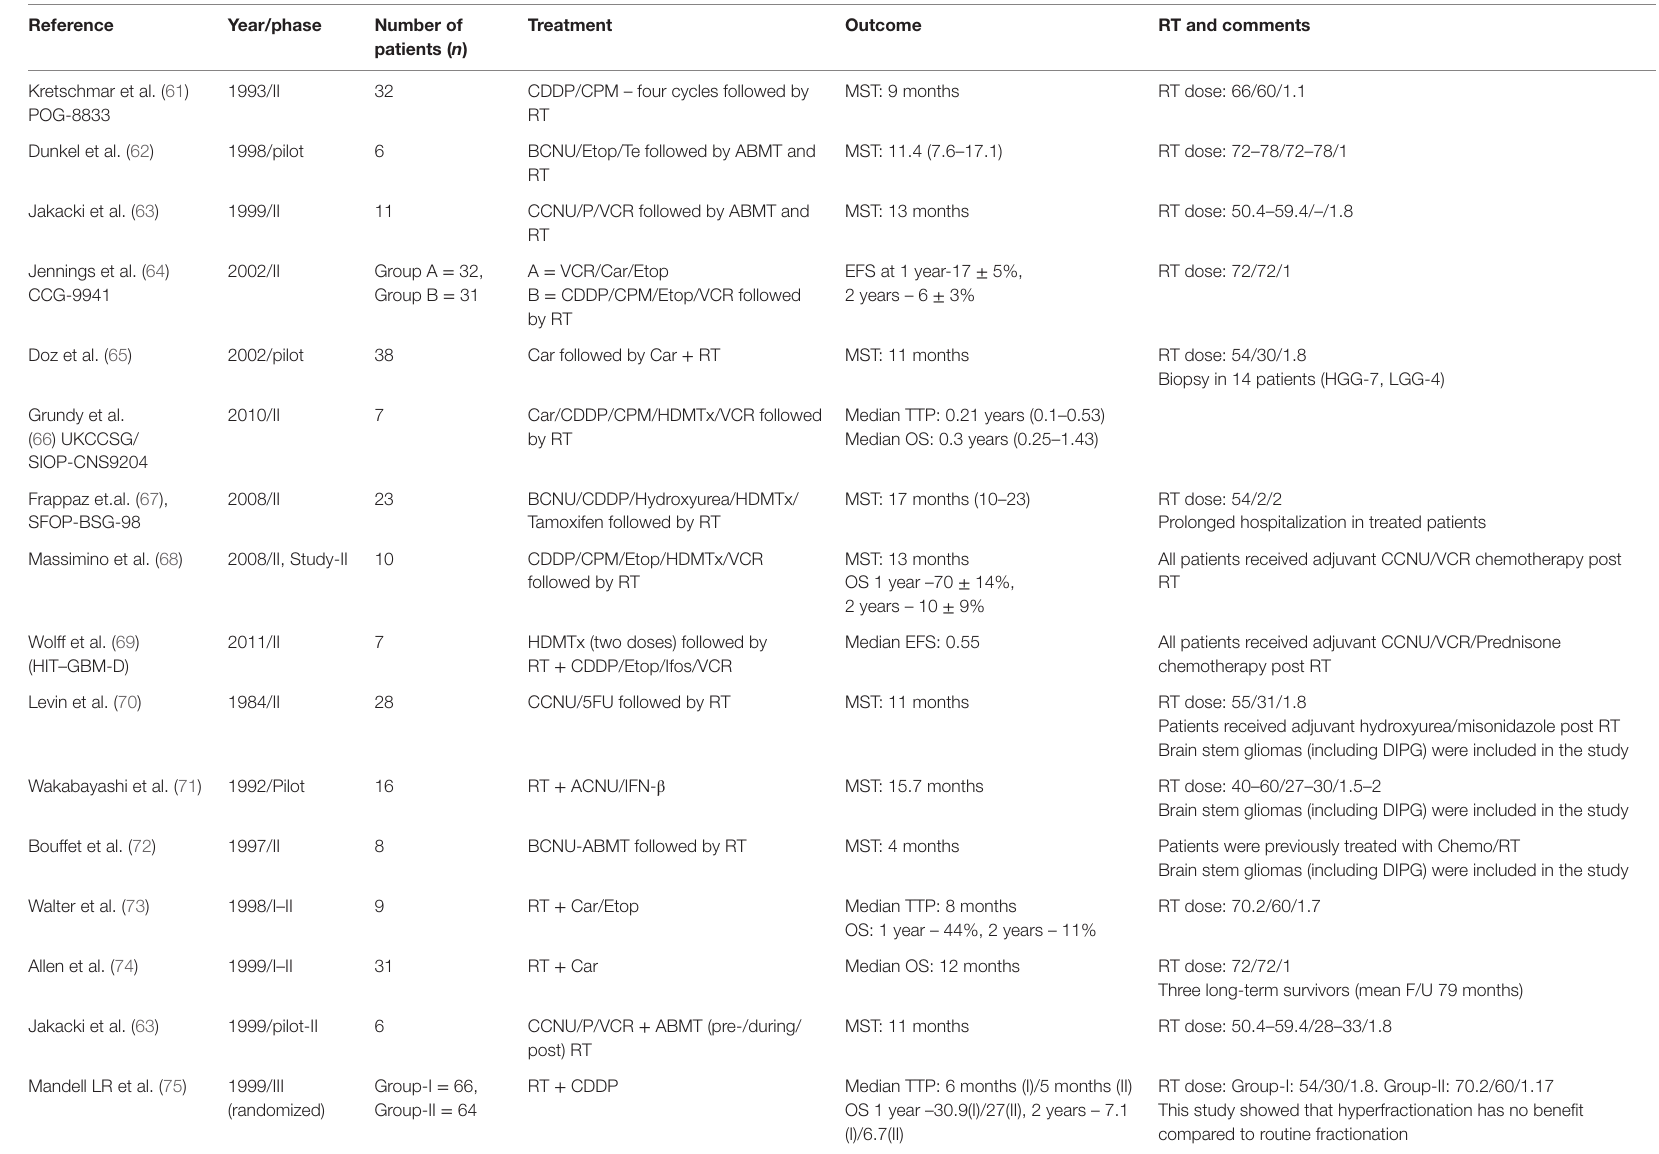
TABLe 3 | (A) Summary of clinical trials of neo-adjuvant chemotherapy and RT in DiPG; (B) summary of clinical trials of Chemotherapy (pre-/concurrent/adjuvant) and RT in